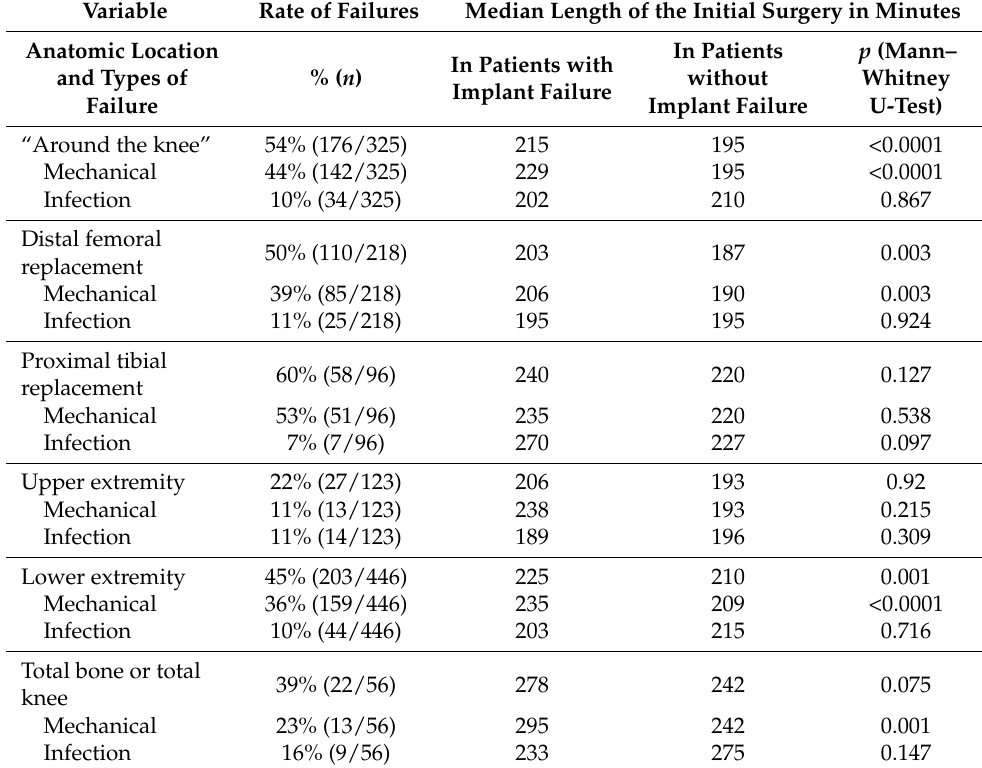
Table 3. Length of surgery for the different anatomic sites of reconstruction, displaying the differ- ences between patients with or without implant failure and distinguishing between infectious and mechanical failures.